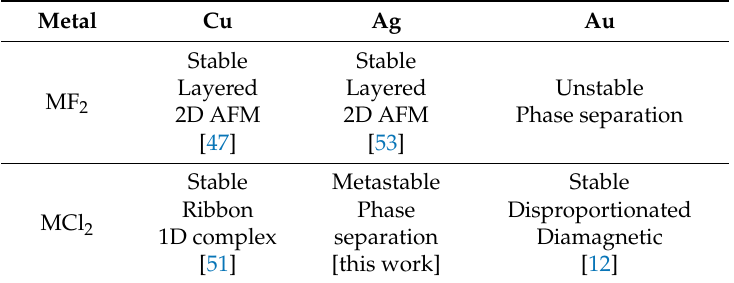
Table 4. Comparison of essential features (stability, structure) and magnetic properties